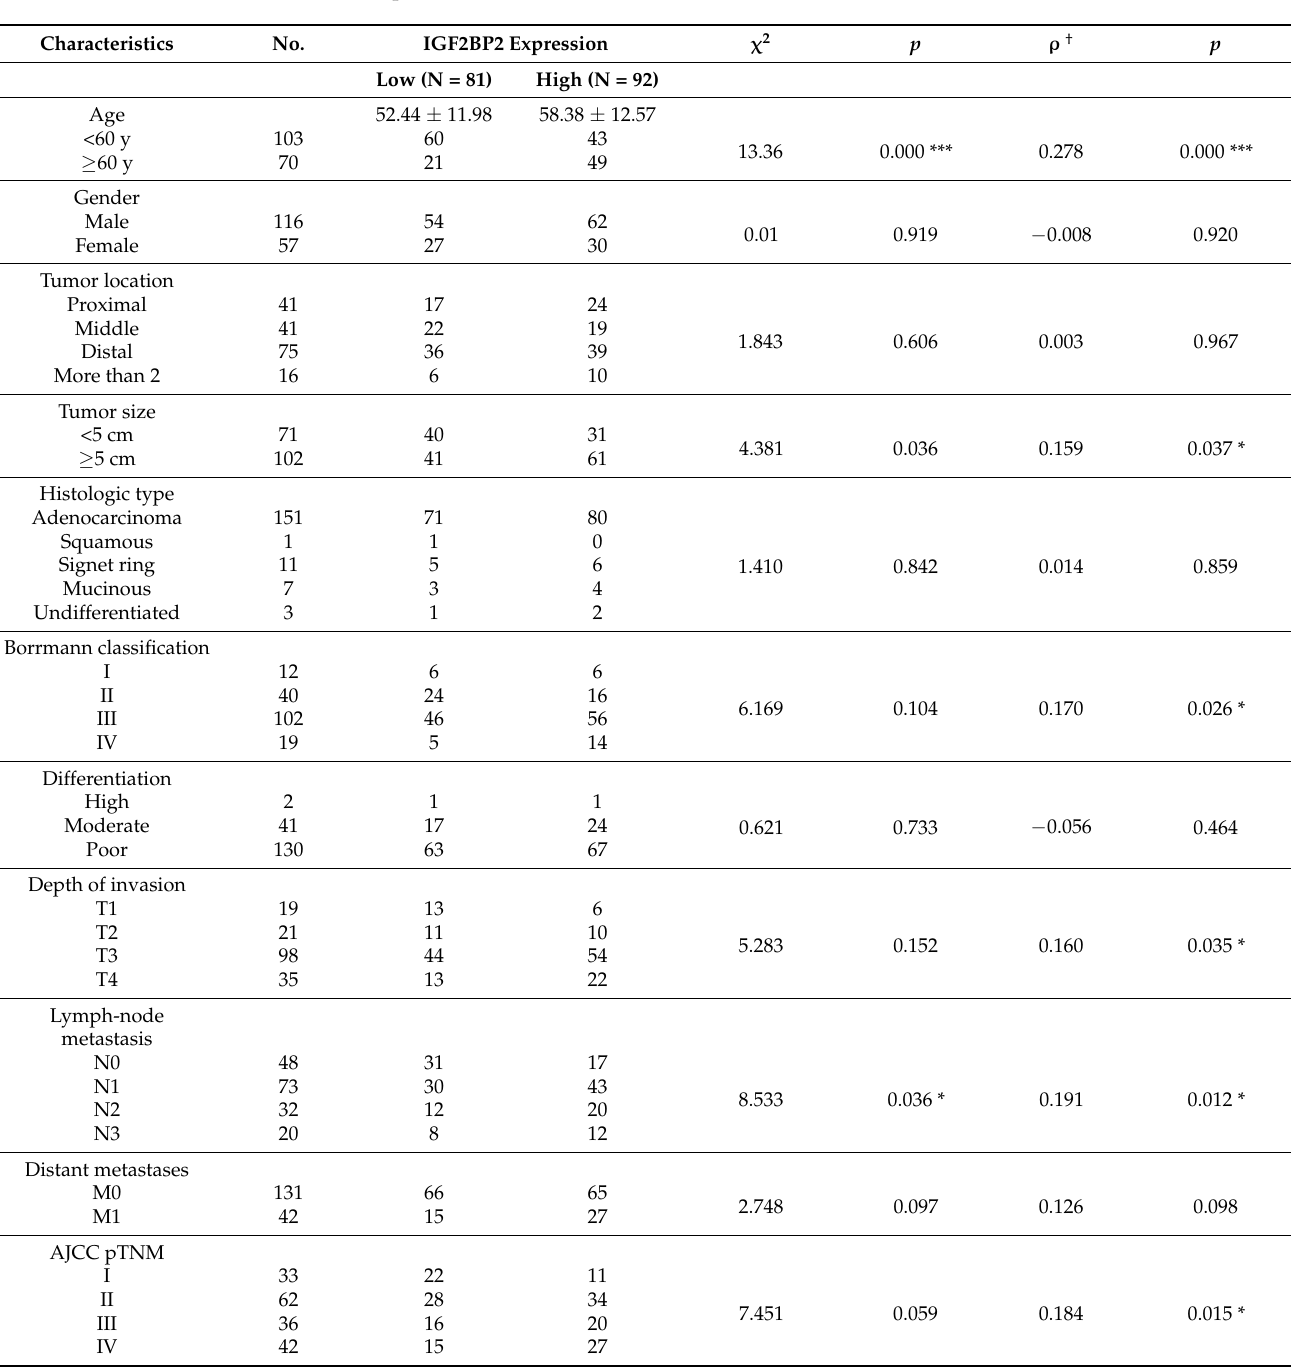
Table 1. Correlations between IGF2BP2 expression and clinicopathologic parameters of 173 GC